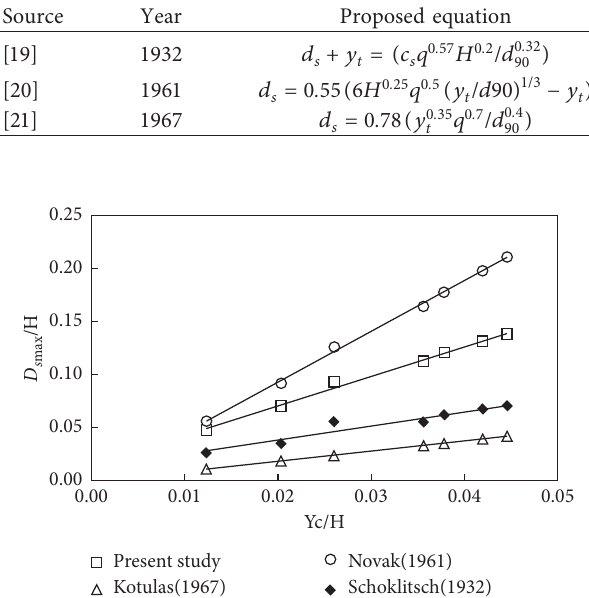
Figure 8: The relationship between dimensionless critical depth and maximum scour depth obtained in this study and comparing the results with those obtained in the literature.